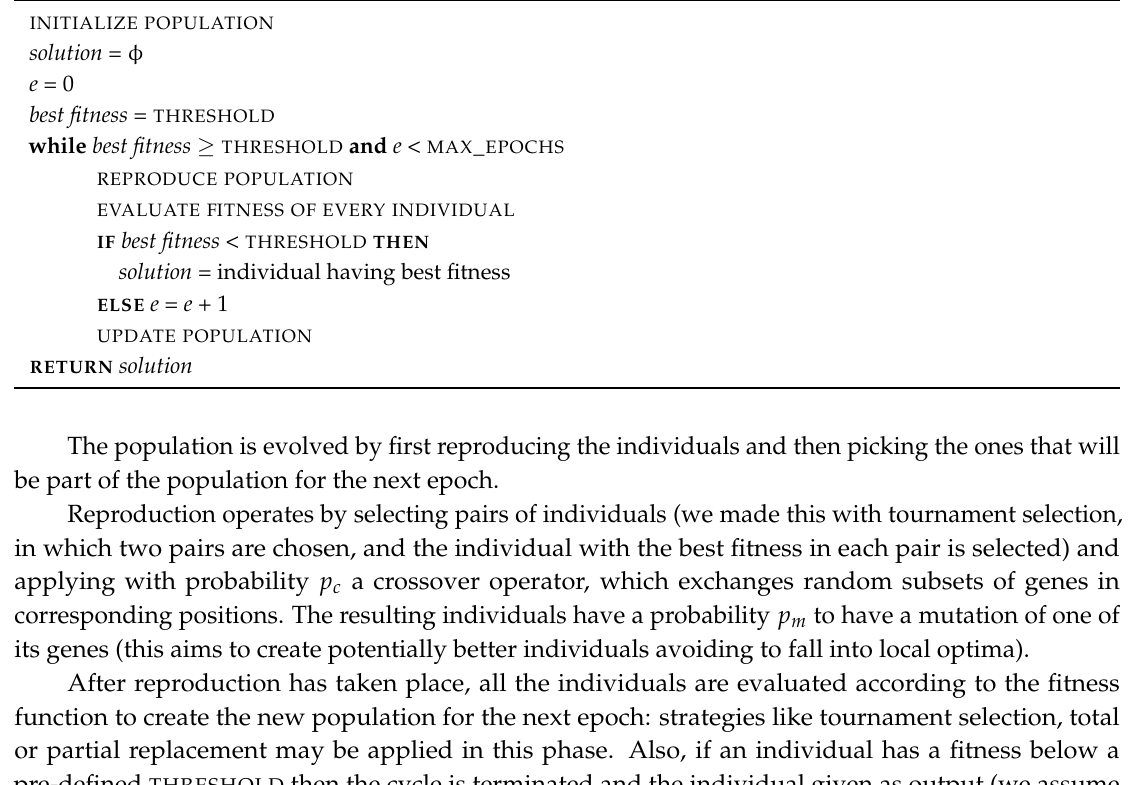
Algorithm 1: G ENETIC